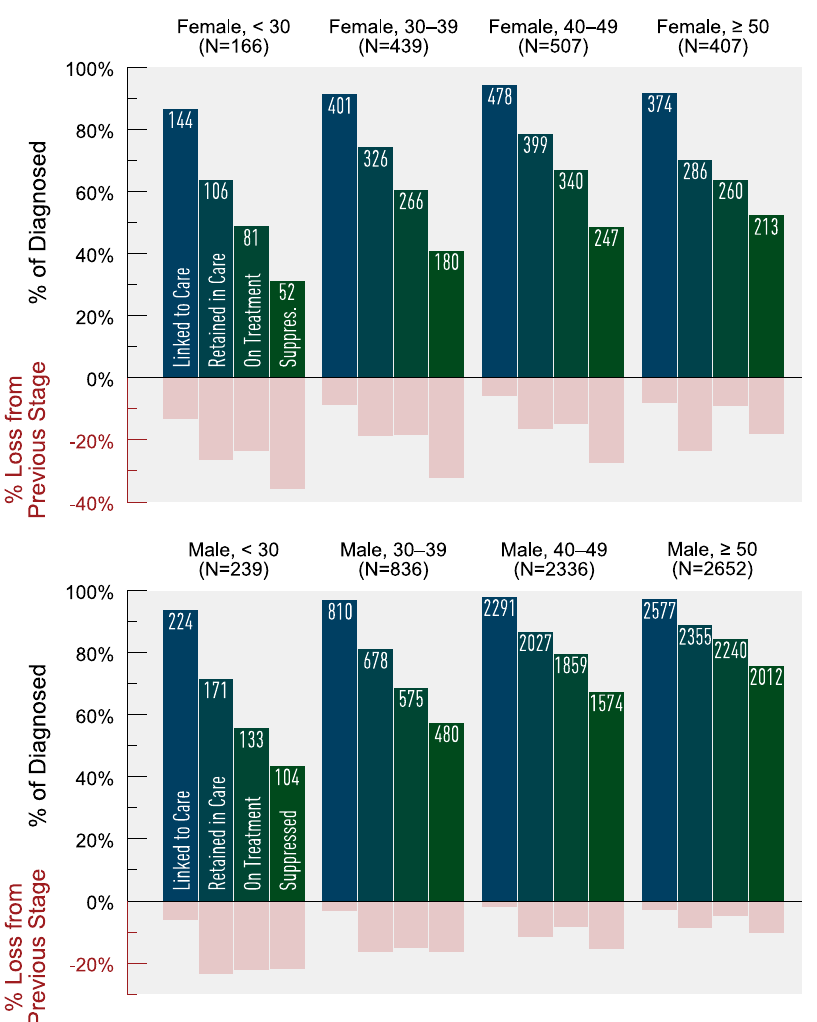
Fig. 3. Estimated HIV cascade of care by age category and sex in 2011 for British Columbia. *Age is defined as age as of January 1 st , 2011. There were 39 HIV-diagnosed individuals with missing gender and age information; none of these individuals were linked to HIV